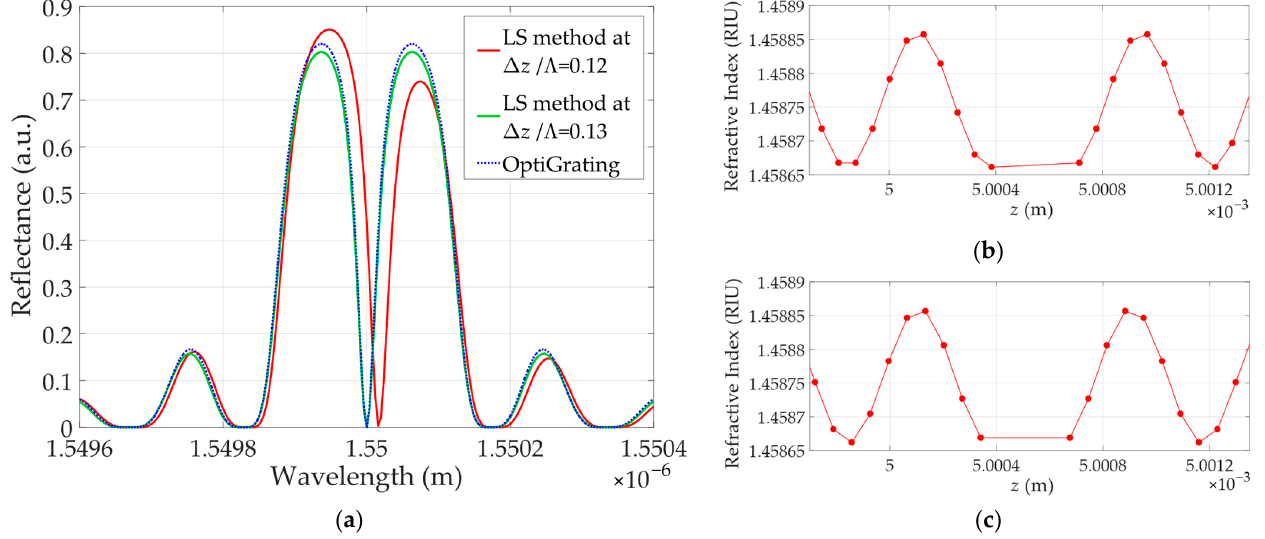
Figure 10. Comparison of modeling results of the π -phase-shifted FBG using the Layer Sweep method at different partition intervals: ( a ) resulting spectra: at ∆ z = 0.12 × Λ (red solid line), at ∆ z = 0.13 × Λ (green solid line), OptiGrating spectrum (blue dotted line); ( b ) refractive index profile of the grating at ∆ z = 0.12 × Λ ; and ( c ) refractive index profile of the grating at ∆ z = 0.13 × Λ